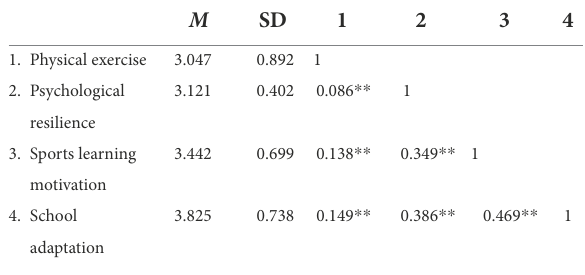
TABLE 2 Average, standard deviation, and correlation coefficient of each